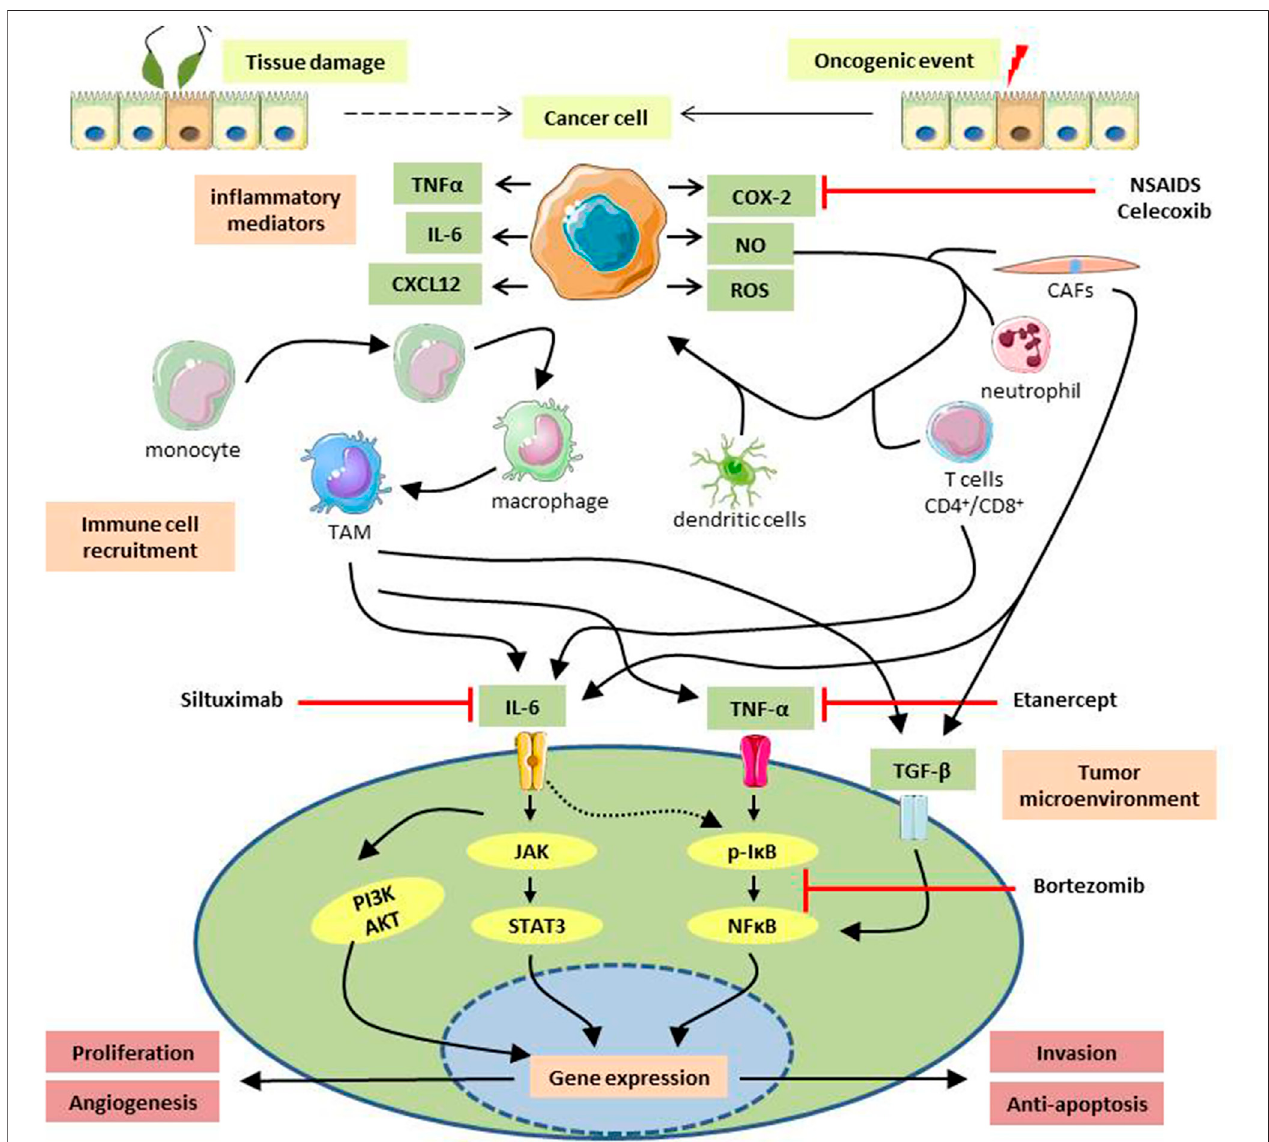
FIGURE1 | Diagrammatic representation of in fl ammation-induced tumorigenesis. Cellular damage caused by external agents, followed by subsequent in fl ammation or initiation of an oncogenic event might transform a healthy cell into a cancerous one. Cancer cells secrete a plethora of soluble factors like chemokines, interleukins, tumor necrotic factors, reactive oxygen/nitrogen species that attracts circulating immune cells to the vicinity. In fi ltrated immune cells, e.g., monocytes, dendritic cells, cancer-associated fi broblasts, neutrophils, CD4 + /CD8 + Tcells, interact with the surrounding cancer cells and secrete potent mediators to establish an in fl ammatory milieu at the tumor site. A low-grade persistent in fl ammation formed as a result can activate various oncogenic signaling pathways which express oncogenes responsible for tumor growth, metastasis, neoangiogenesis, etc., and help in the progression of malignancies. Anti-in fl ammatory drugs used to treat gynecological cancers are NSAIDs e.g., celecoxib, COX-2 inhibitor; Etanercept, soluble TNF- α blocker; siltuximab, IL-6 blocking antibody; Bortezomib, an inhibitor of NF κ B activation. TNF- α , Tumor-Necrotic Factor α ; IL-6, Interleukin-6; CXCL12, CXC Motif Chemokine Ligand 12; COX-2, cyclooxygenase two; NO, Nitric Oxide; ROS, Reactive Oxygen Species; TAM, Tumor-Associated Macrophage; CAFs, Cancer-Associated Fibroblasts; TGF- β , Transforming Growth Factor β ; JAK, Janus Activated kinase; STAT3, Signal Transducer And Activator Of Transcription three; PI3K, Phosphoinositide three kinase; AKT, Protein kinase B; I κ B, Inhibitor Kappa B; NF κ B, Nuclear Factor Kappa